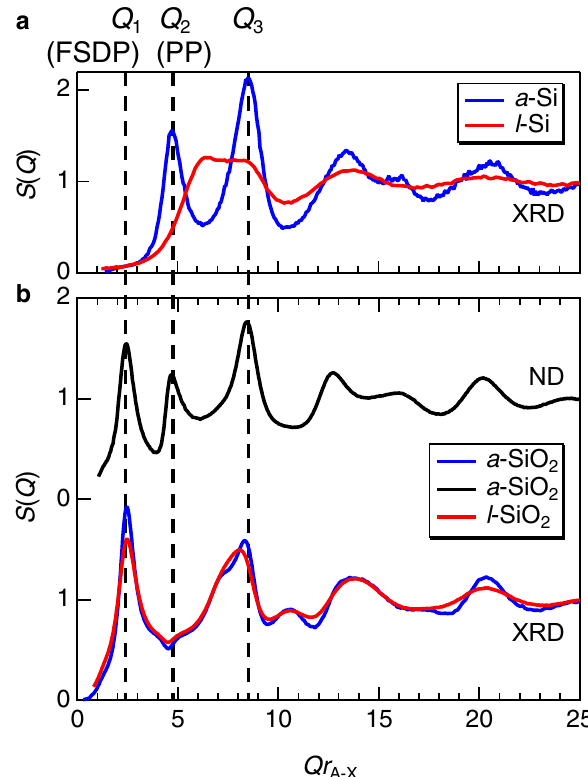
Figure 2. ( a ) X-ray structure factors, S ( Q ), for a -Si 8 and l -Si (1770 K) 29. . (b) X-ray structure factors, S ( Q ), f or a -SiO 2 29 and l -SiO 2 (2019 K) 51 , together with neutron S ( Q ) 30 for a -SiO 2 . Scattering vector Q is scaled by multiplying by Qr A-X (first coordination distance) obtained by a Fourier transform of S ( Q ). r A-X = r Si-Si = 2.35 Å and 2.45 Å for a -Si and l -Si, and r A-X = r Si-O = 1.61 Å and 1.62 Å for a -SiO 2 and l -SiO 2 ,